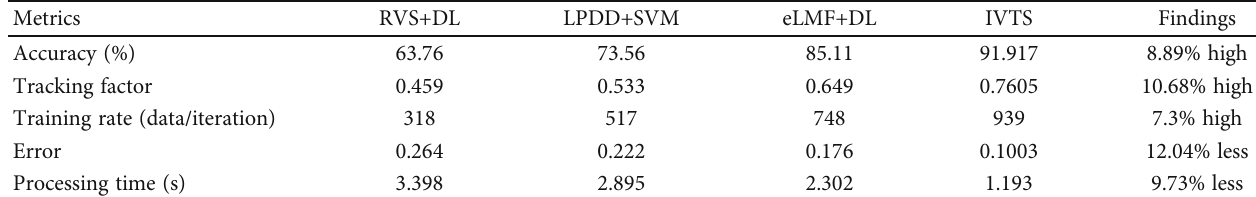
Table 2: Comparative analysis results for similarity factor.